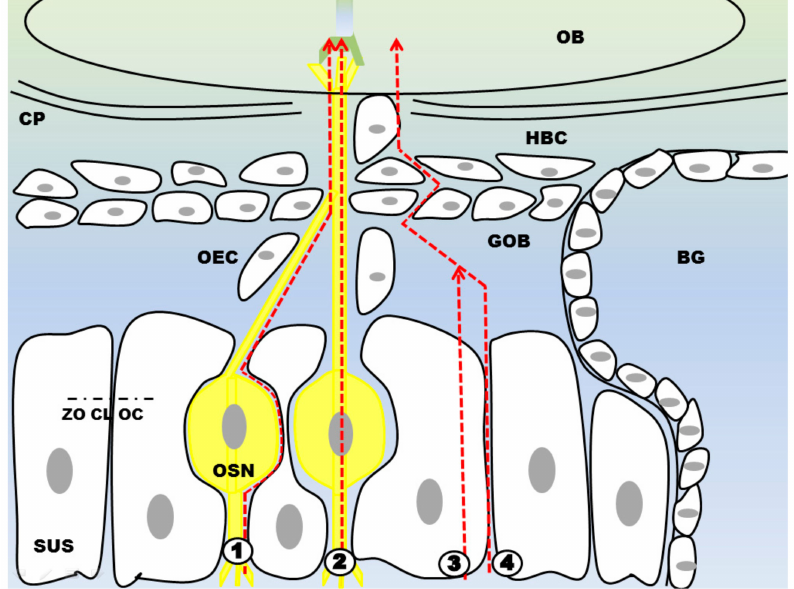
Figure 7. Four different routes have been described for N2B drug delivery. The extracellular pathway 1 (cid:13) directs the drug to the CNS along the OSN (or trigeminal nerve which is not shown here) via bulk flow processes. For the intracellular route 2 (cid:13) the drug is endocytosed and then shuttled to the CNS where it is finally exocytosed. 3 (cid:13) and 4 (cid:13) describe drug transport through or along supporting cells. The drug molecule can either be endocytosed by supporting cells or travel through the intercellular space. By travelling through the intercellular space 4 (cid:13) the drug has to pass tight junctions like zonula occludens (ZO), claudin (CL) and occludin (OC). It should be noted that intranasal drug delivery is rather a mixture of these different pathways than being limited to one only. Abbreviations: SUS: sustentacular cells; OSN: olfactory sensory neuron; OEC: olfactory ensheathing cell; GOB: globose basal cells; HBC: horizontal basal cells; BG: Bowman’s gland; CP: cribriform plate; OB: olfactory